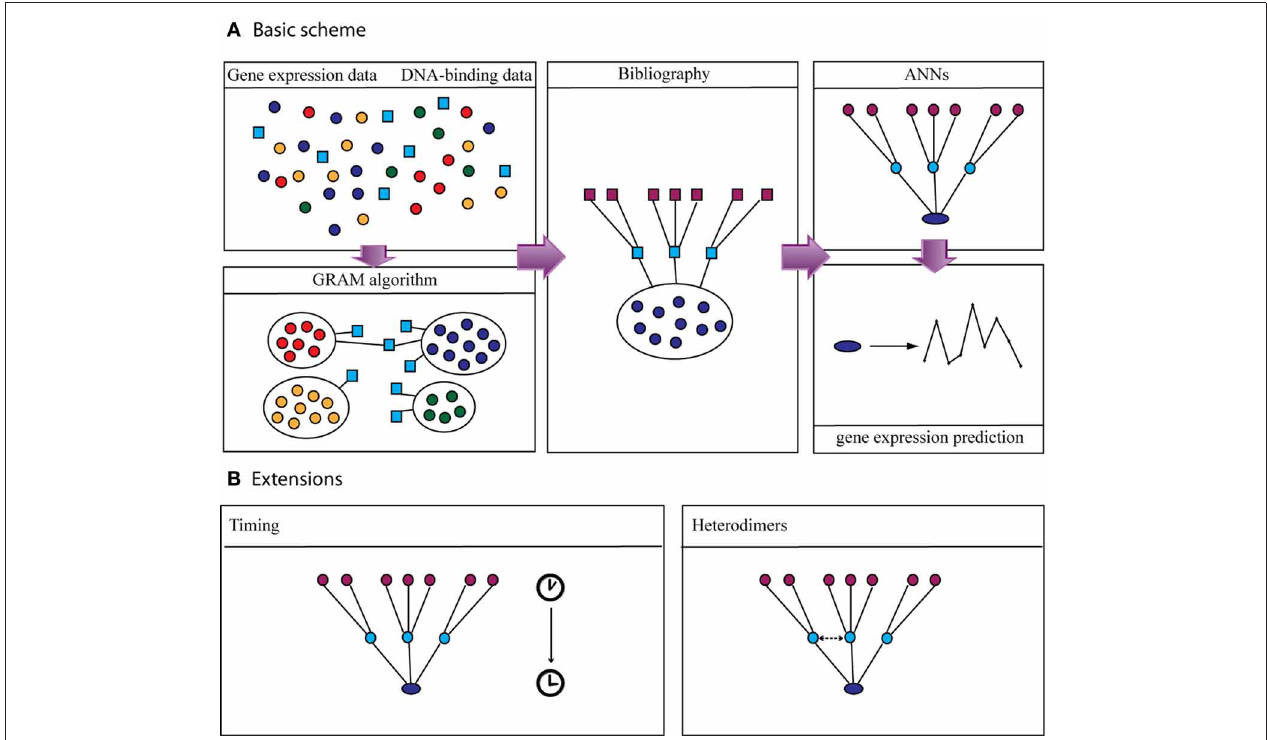
FIGURE 2 | Flow chart of the proposed method. (A) Left panel: Gene expression data from microarray studies and DNA-binding data (ChIP-chip) are used as input to the GRAM algorithm in order to identify gene modules and their regulators. Middle panel: Bibliographical information from public databases is used to add another layer of regulators and build the three-layer regulatory cascade. Right panel: ANNs with the